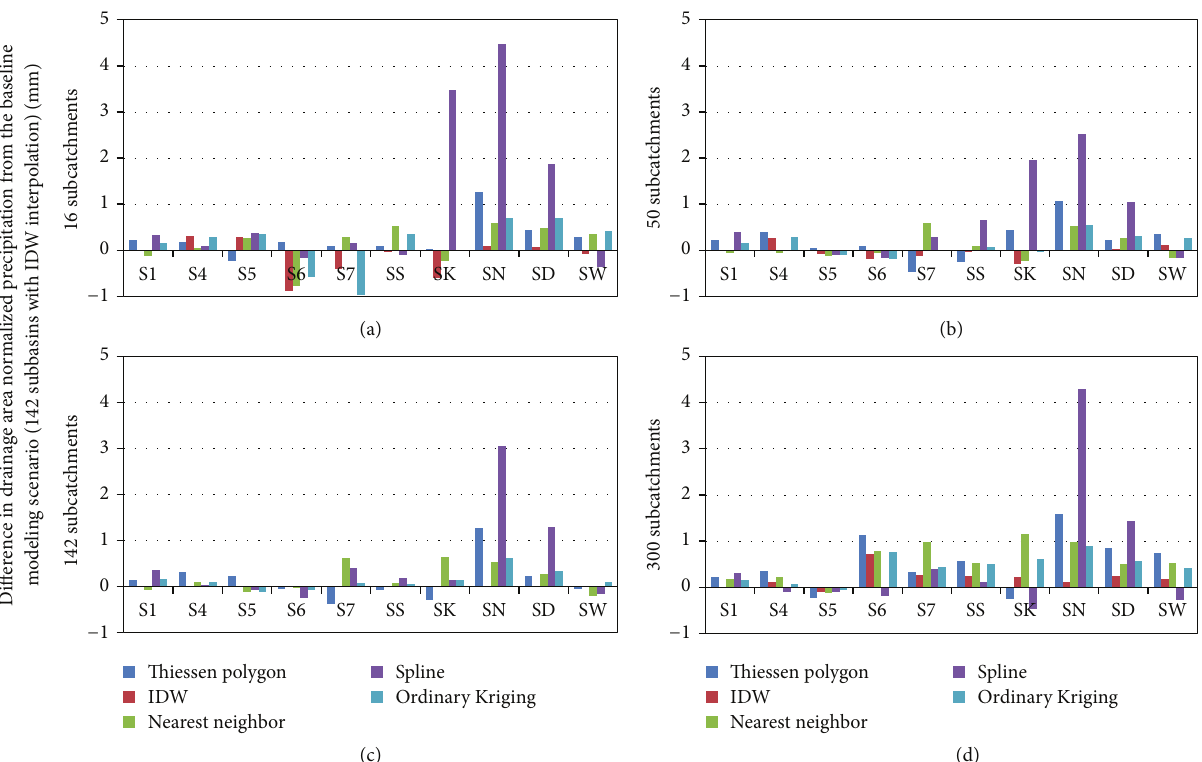
Figure 5: Difference in average annual precipitation from the calibrated 142-subbasin IDW amount as described by Shope et al., 2014. The panels represent the difference for each of the 5 interpolation methods at each drainage area for the (a) 16 observed, (b) 50 simulated, (c) 142 simulated, and (d) 300 simulated meteorological